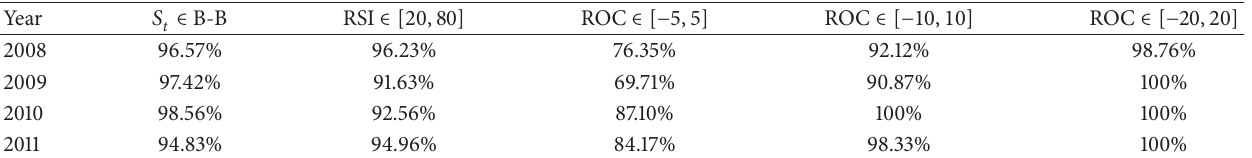
Table 3: Ratio of DIA in